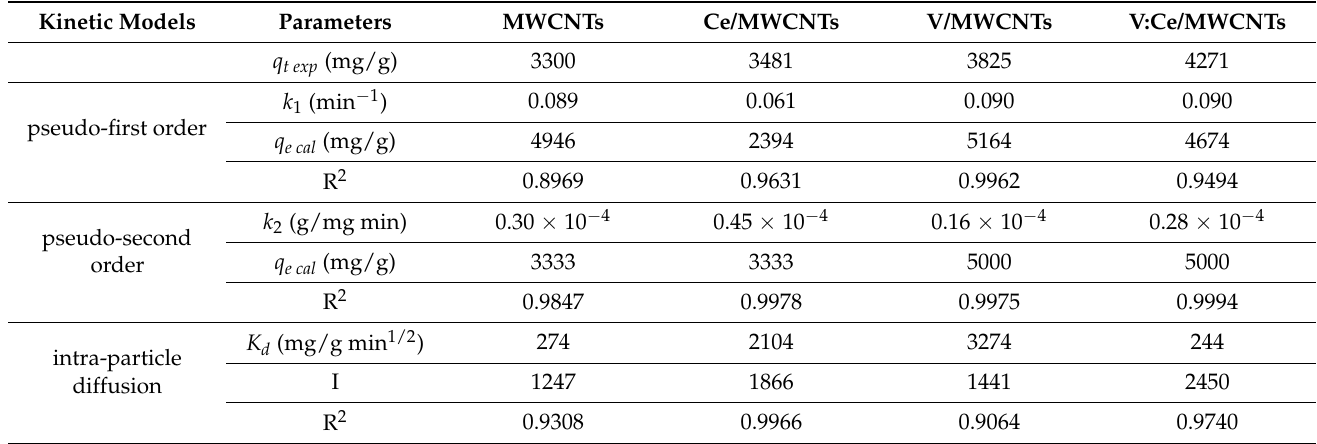
Table 4. Parameters of the applied kinetic model equations with regard to kerosene adsorption from the aqueous solution onto the samples